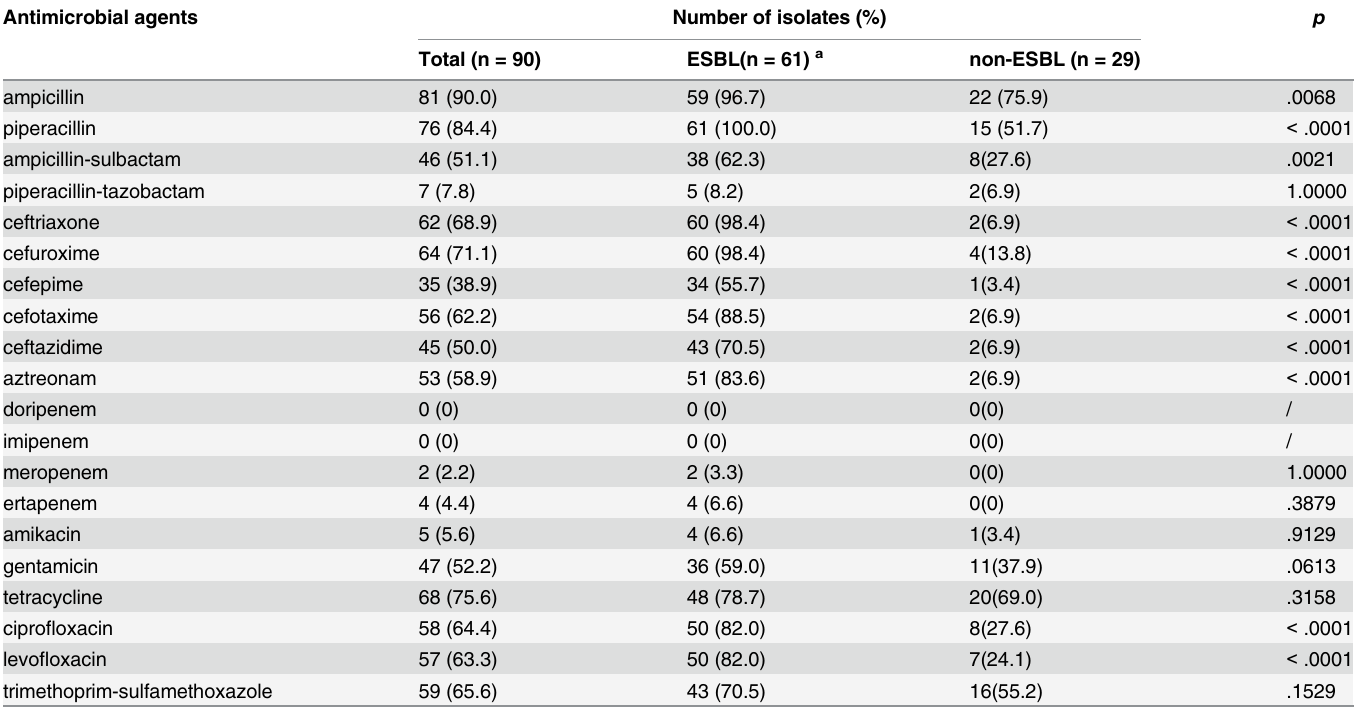
Table 2. Antimicrobial Resistance ofNinety E . coli isolates from Bloodstream Infections. Antimicrobial agents